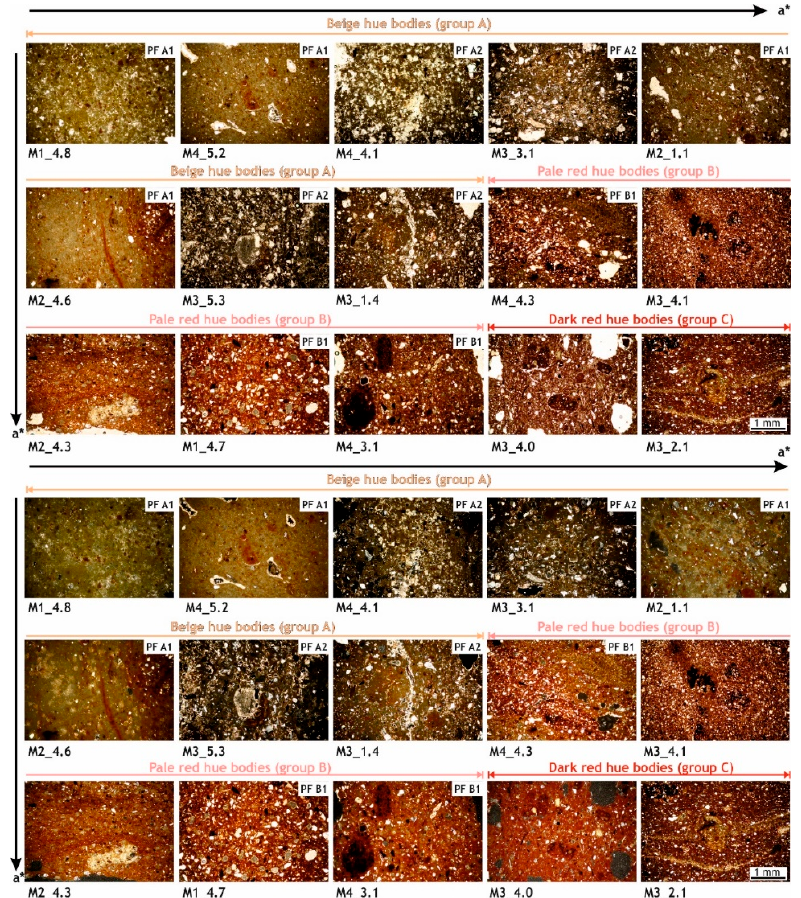
Figure 8. Photomicrographs in plain-polarized light ( above ) and crossed-polarized light ( below ) of the beige, pale and dark red hue ceramic bodies, ordered according to the increase of the red component (a* chromatic coordinate). Three general petro-fabrics were stated: A1 (M1_4.8, M4_5.2, M2_1.1 and M2_4.6), A2 (M4_4.1, M3_3.1, M3_5.3 and M3_1.4) and B1 (M4_4.3, M1_4.7 and M4_3.1). Samples M3_4.1, M2_4.3, M3_4.0 and M3_2.1 do not belong to any of these general petro-fabrics. Images were taken at the same magnification.